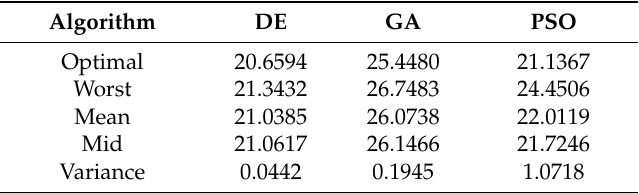
Table 10. Comparison of algorithm